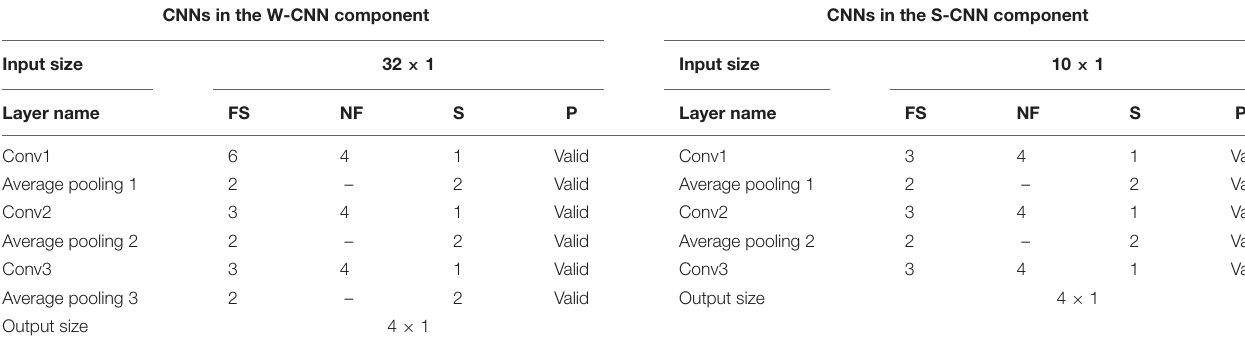
FIGURE 1 | The architecture of the proposed base network. prcp, t_max, and gdd represent precipitation, maximum temperature, and growing degree days, respectively. S1, S2, ... , and S10 are 10 soil variables which each are measured at 10 depth levels. Y_hat represents the final corn yield prediction made by the model. TABLE 1 | Detailed structure of the CNN networks of CNN components designed as the foundation for ensemble neural